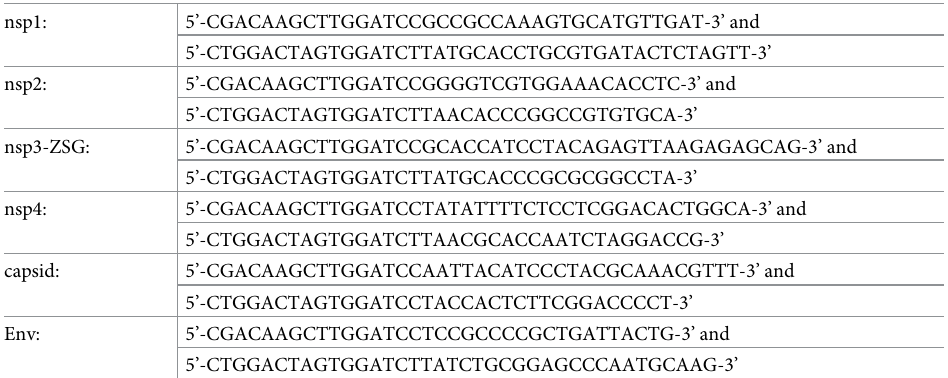
pcDNA5.3xFLAG-nsp4, pcDNA5.3xFLAG-capsid and pcDNA5.3xFLAG-Env, which